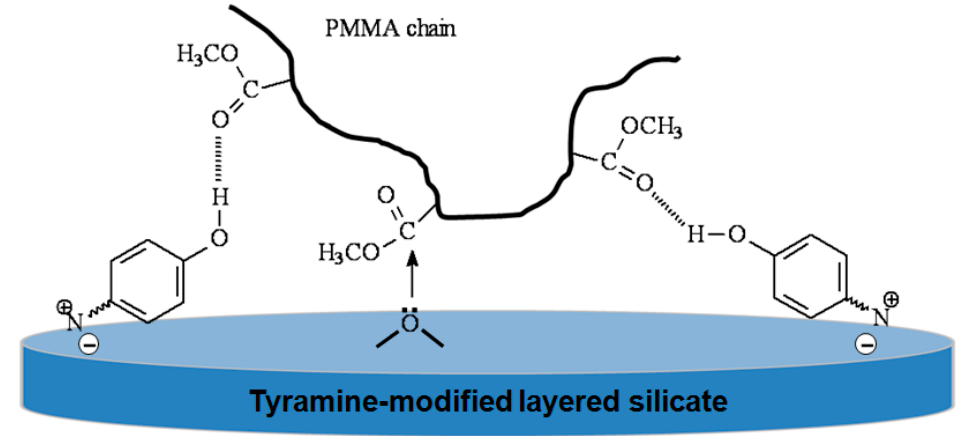
Figure 12. Schematic showing interaction and hydrogen bonding between modified clay and